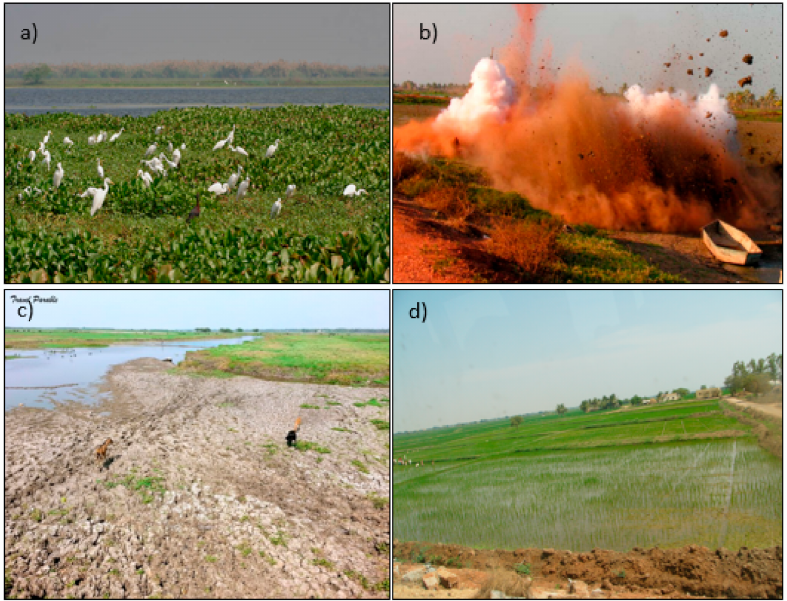
Figure 2. ( a ) Coverage of aquatic weeds (Photo by J.M.Garg, 9 October 2008); ( b ) demolition of illegal fishponds by the “Operation Kolleru” program during 2005–2006 [48]; ( c ) marshy areas (Google image); and ( d ) paddy crops grown in the lake catchment area (Photo by Opp,